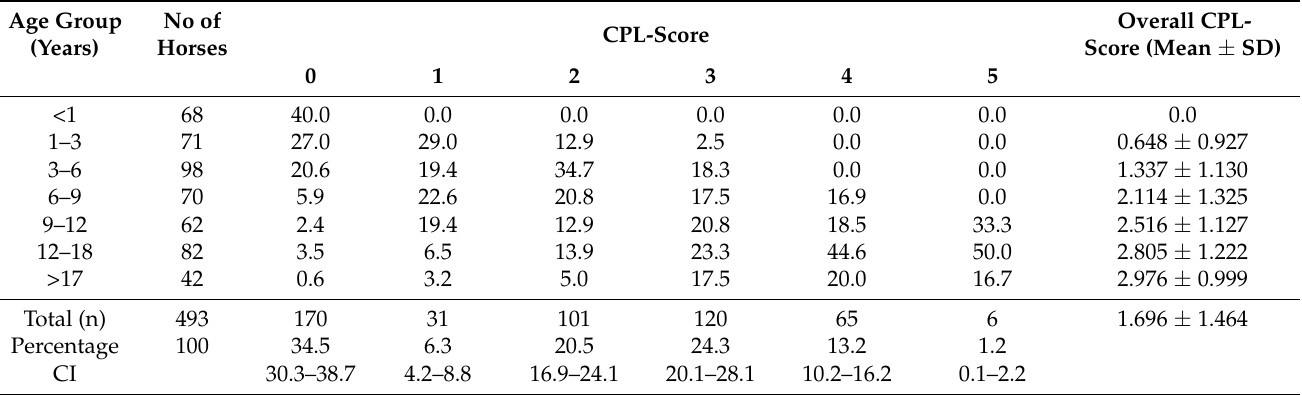
Table 2. Percentage and 95% confidence intervals (CI) of horses by scores of chronic progressive lymphedema (CPL) and age groups in 493 Rhenish German draught horses.